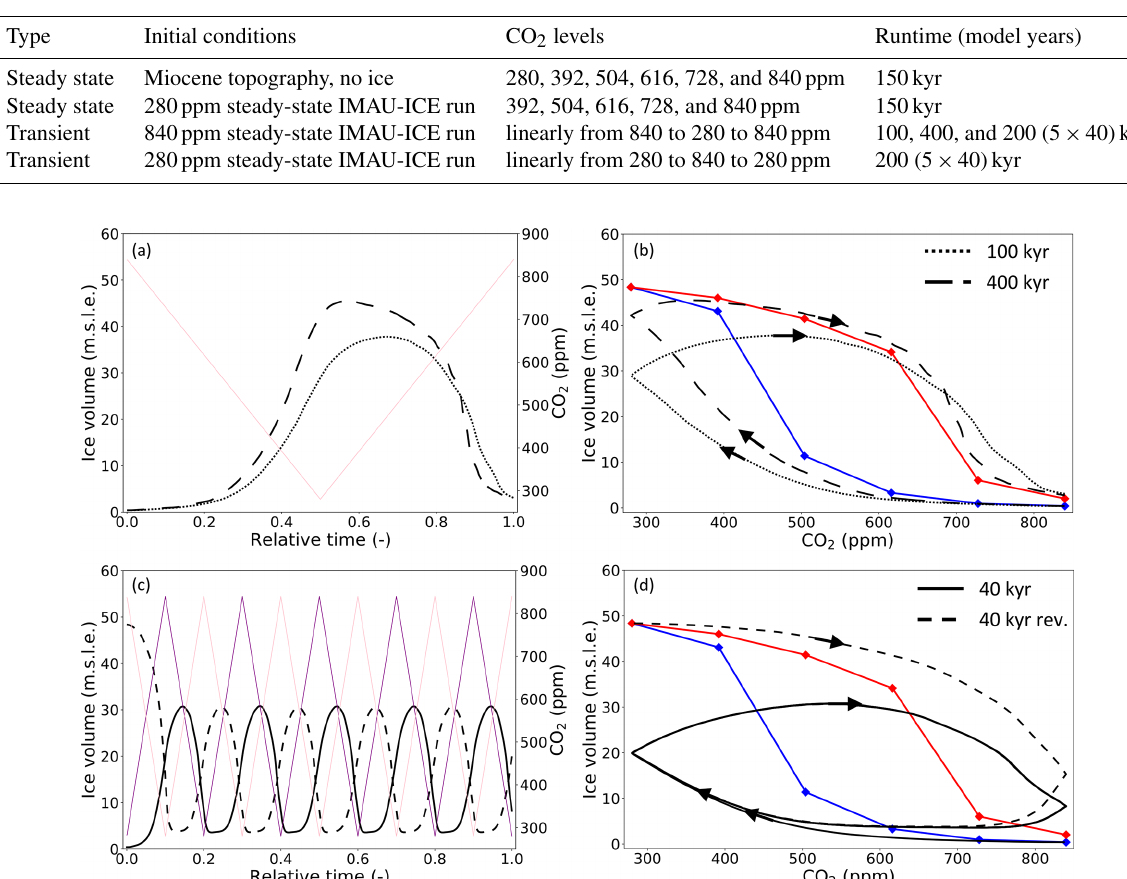
the high mountainous regions at ∼ 0.1 m s.l.e. kyr − 1 ,